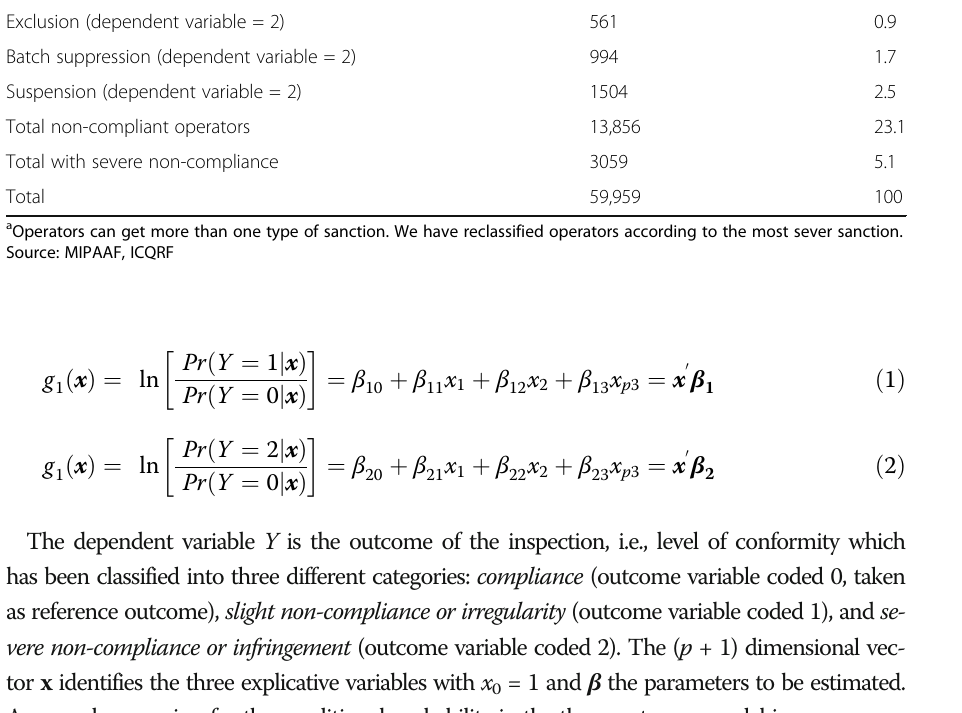
Table 3 Distribution of organic firms by type of sanction in 2015 Type of sanction a N % No sanction (dependent variable =